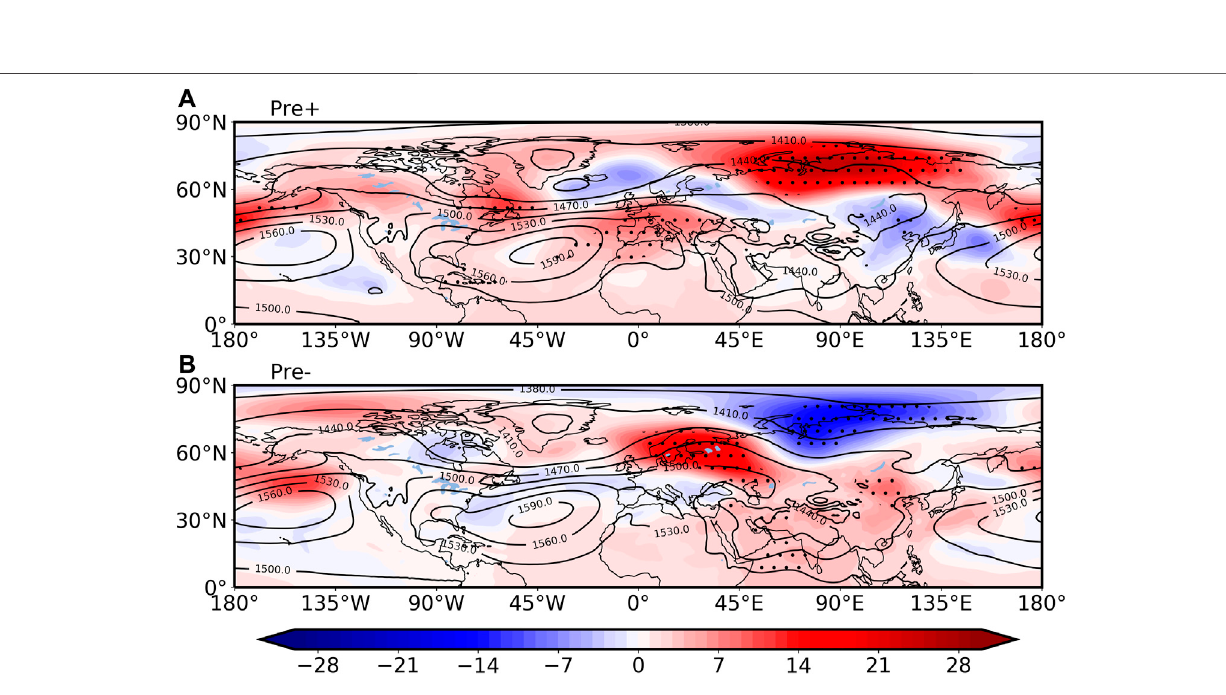
FIGURE 5 | 850 hPa summer geopotential height fi eld anomalies (shaded) and 850 hPa summer mean geopotential height fi eld (contours) composite for wet (A) and dry (B) years in the semi-arid regions of East Asia (units: gpm). Stippling denotes the region with statistical signi fi cance at the 90% con fi dence level based on Student ’ s